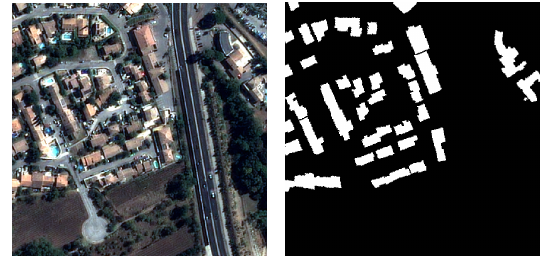
Figure 1. Pl´eiades (PHR) image of Montpellier with the associated building